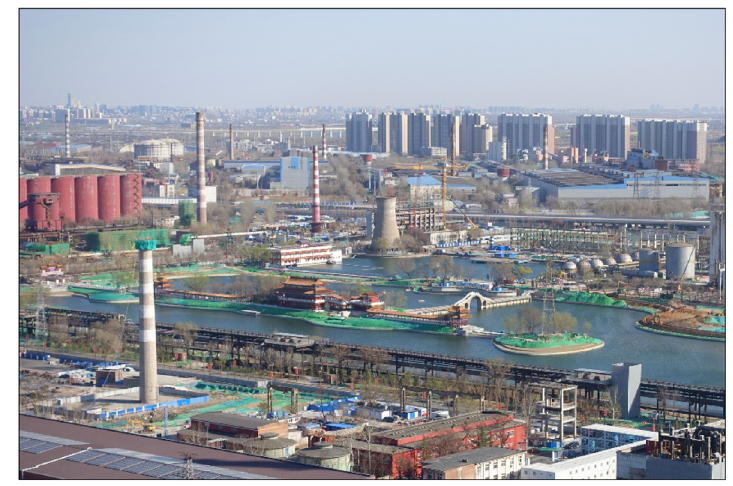
Fig. 8 Shougang Park Regeneration